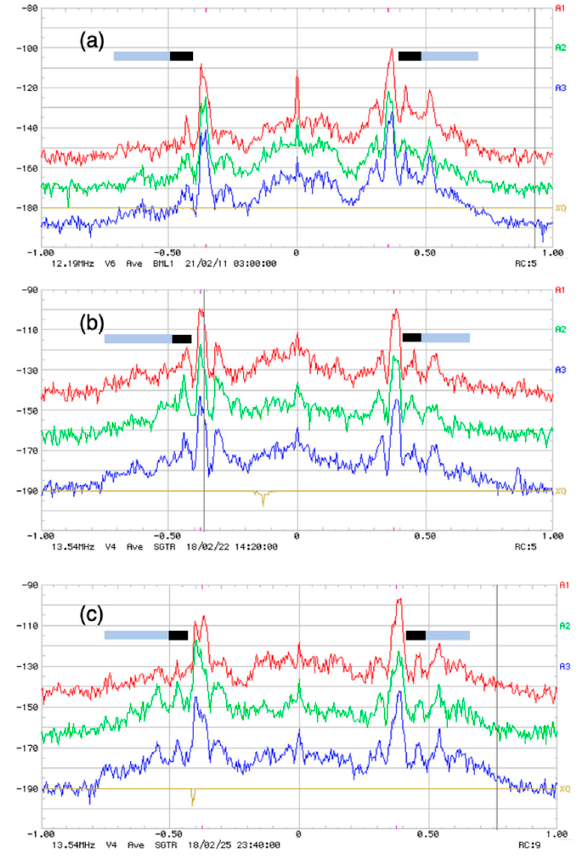
Figure 1. Examples of SeaSonde monopole spectra exhibiting separated regions in the second-order spectrum due to swell and wind-waves; Loop 1 (red), Loop 2 (green), Monopole (blue). Signal strength (dB) is plotted vs. Doppler frequency (Hz). The spectra exhibit narrow spectral peaks close to the first-order Bragg region produced by swell, in addition to the broader echo from